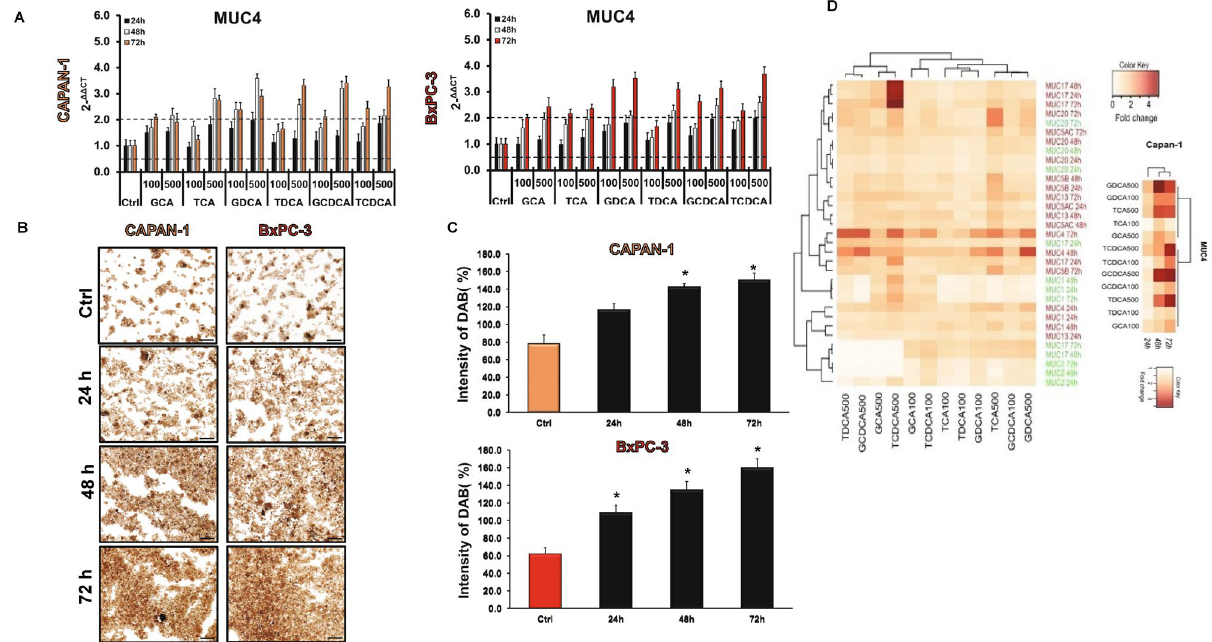
Figure 4. Effects of bile acid treatment on the mRNA and protein expression of mucins in pancreatic ductal cells. ( A ) Capan-1 and BxPC-3 cells were treated with different bile acids (BAs) for 24, 48 and 72 h and the relative gene expressions of MUC4 gene was investigated by real-time PCR. ( B ) Representative immunofluorescence staining of Capan-1 and BxPC-3 cells shows the expression of MUC4 after the treatment with taurochenodeoxycholic acid (TCDCA; 500 μM) for 24, 48 and 72 h. ( C ) Quantification of MUC4 protein expression. Specimens were scanned using Olympus IX83 based system (Olympus cellSense Dimension software version 2.3, https ://www.olymp us-lifes cienc e.com/en/softw are/cells ens/) and DAB staining intensities were analysed by ImageJ software. Data represent mean ± SEM of three, independent experiments. * = p ≤ 0.05 vs. Control. Scale bar represents 100 µm. ( D ) The cluster analysis and dendrogram show the difference between the effect of BAs treatment at different concentrations and time points. Red and white colours indicate high and low expression, respectively. (Values represent the fold change in the gene expression level of MUC genes). Data represent mean ± SEM of three, independent experiments. GCA glycocholic acid, TCA taurocholic